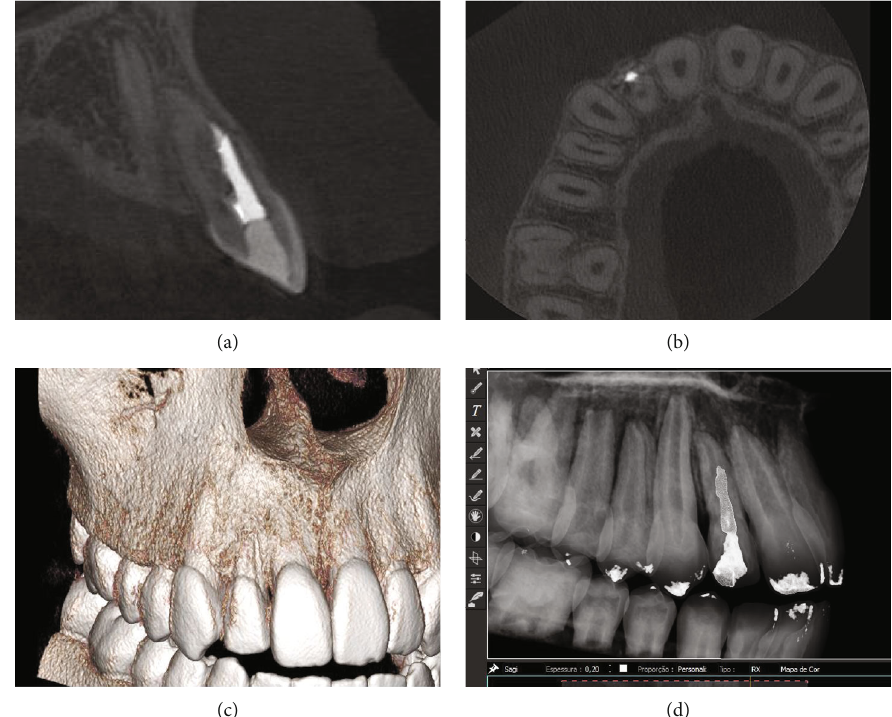
Figure 5: (a – d) CBCT scan and 3D reconstructions two years after the surgery show healing process of the buccal bone and absence of signs of in fl ammation in the root